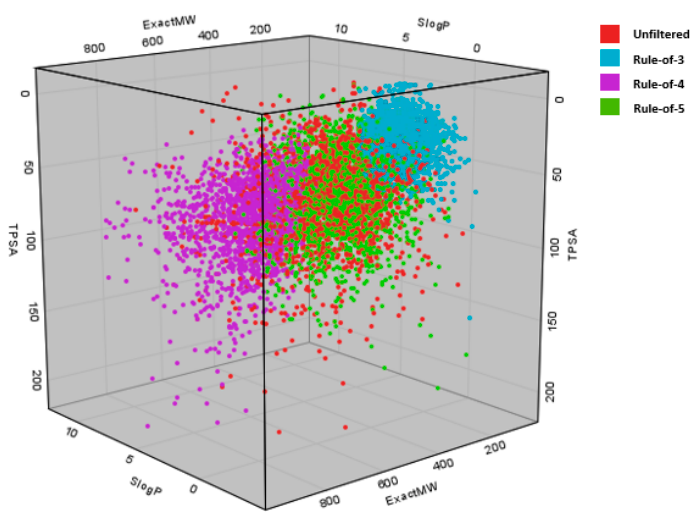
Figure 6. A 3D scatterplot of exact molecular weight, SlogP, and total polar surface area (TPSA) for the unfiltered (red) and filtered Rule-of-3 (Blue), Rule-of-4 (purple), and Rule-of-5 (green). We can see how the space occupied by compounds changes drastically; similar observations can be made as in the case of the 2D plot in Figure